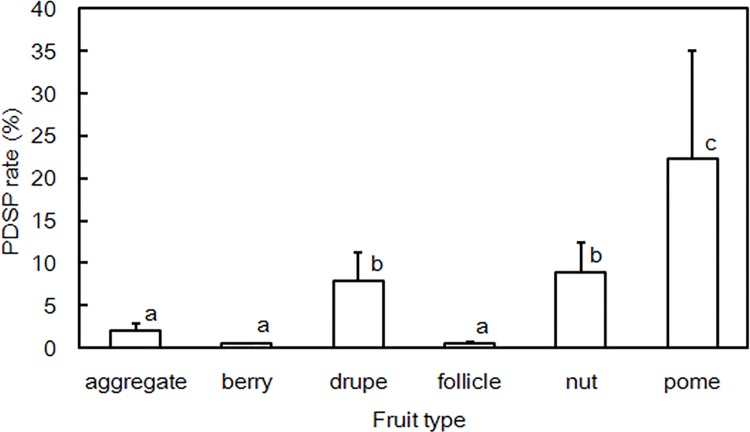
PDSP rates of six fruit types in the seven years of study.The boxes are mean PDSP rates, and the error bars indicate the standard errors. The pair-wise differences in mean predation rates between fruit types were examined with a non-parameterized Kruskal-Wallis test, and a, b, c represents significantly different mean values.